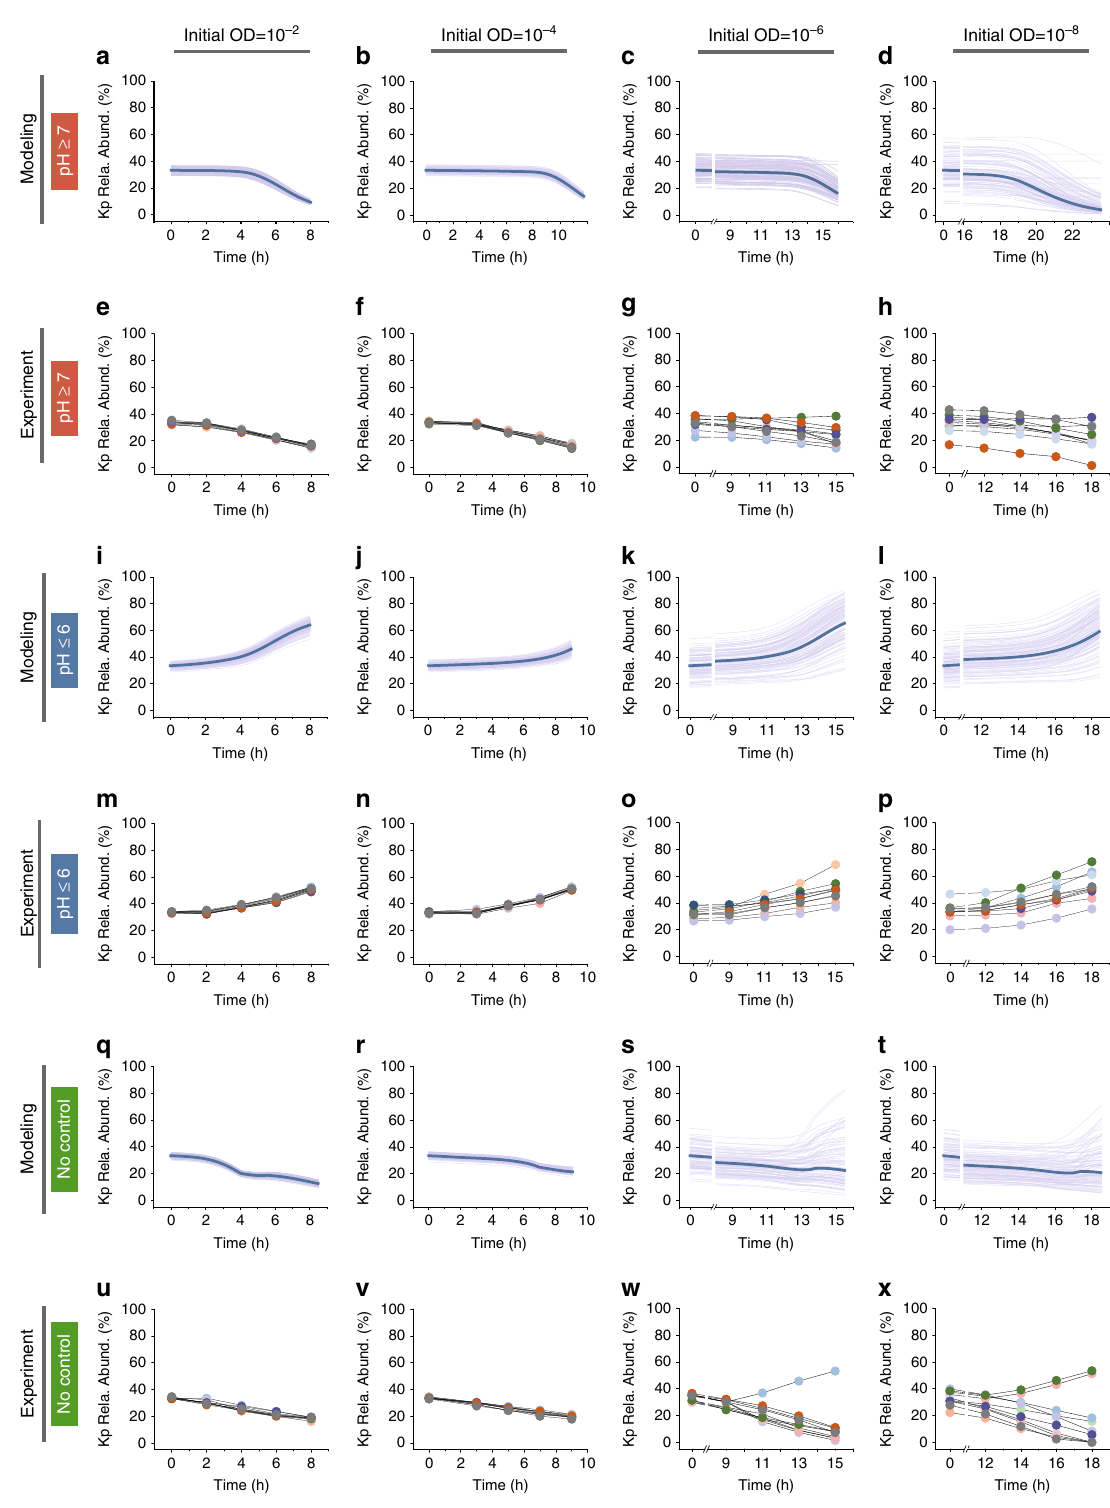
Fig. 7 Model-predicted and experimentally measured succession of the C α -C β -Kp ecosystem for varied pH conditions and initial densities. a – h Predicted ( a – d ) and experimentally measured ( e – h ) time courses of Kp abundance in the C α -C β -Kp consortium when pH ≥ 7. i – p Predicted ( i – l ) and measured ( m – p ) time courses of Kp abundance in the C α -C β -Kp consortium when pH ≤ 6. q – x Predicted ( q – t ) and measured ( u – x ) time courses of Kp abundance in the C α -C β -Kp consortium when there is no pH control. For both model predictions and experimental measurements, the co-culture was inoculated at 1:1:1 ratio but the initial OD was varied from 10 − 2 ( fi rst column) to 10 − 4 (second column), 10 − 6 (third column) and 10 − 8 (fourth column). For each condition, a total of 100 simulation replicates and 10 experimental replicates were performed. For comparison, the deterministic dynamics of Kp without sampling-induced variability were displayed with bold lines in a – d , i – l , and q – t . Source Data available in the source data fi